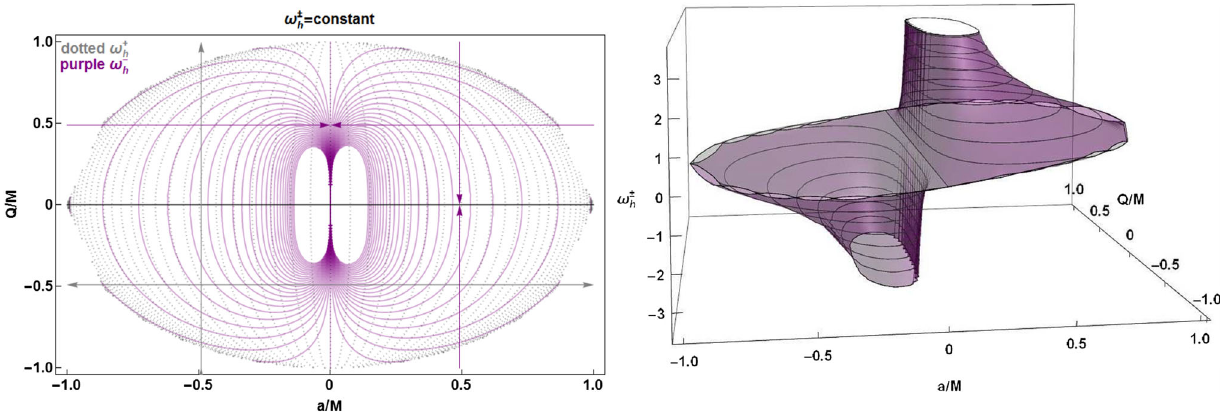
as functions of the H